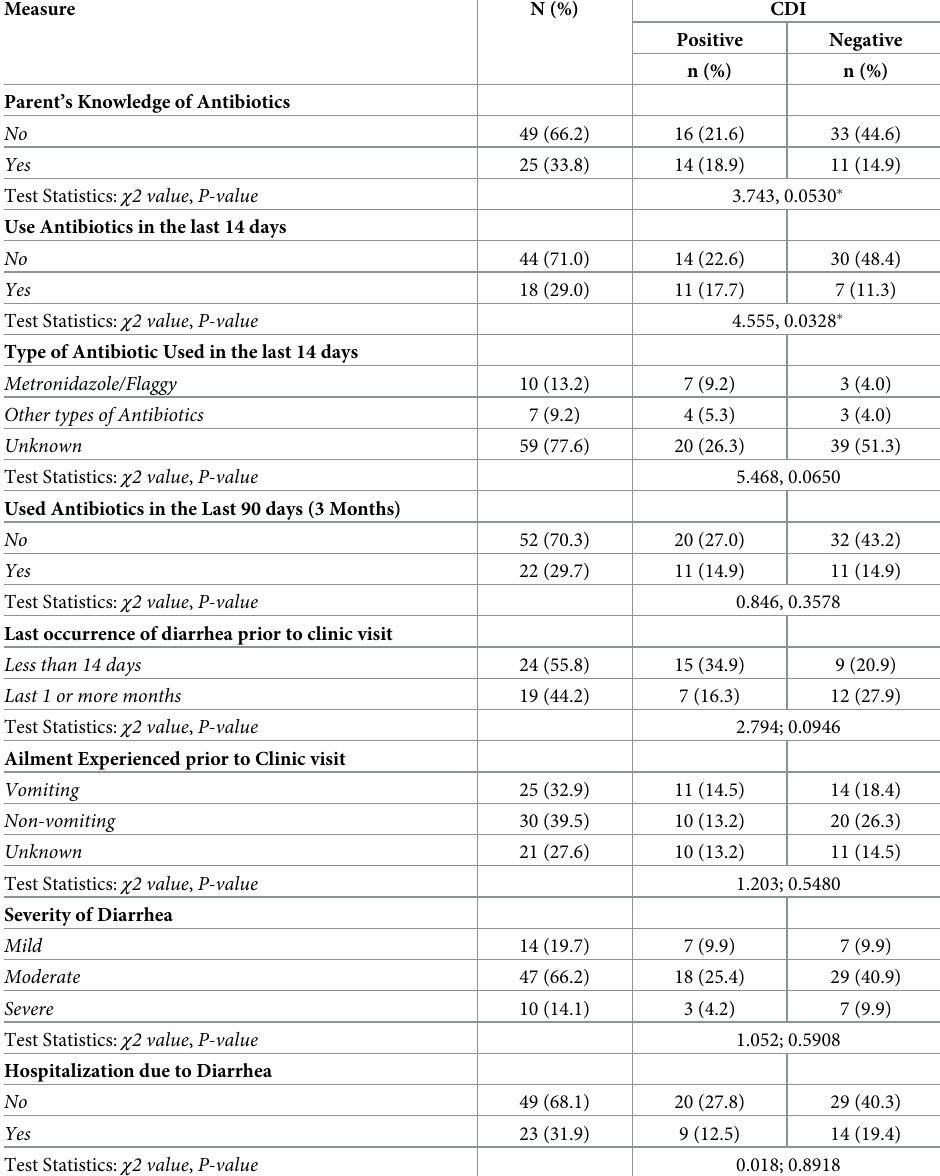
Table 2. History of antibiotics used by the patients, presence of toxigenic C . difficile , and disease severity among pediatric patients with diarrhea.